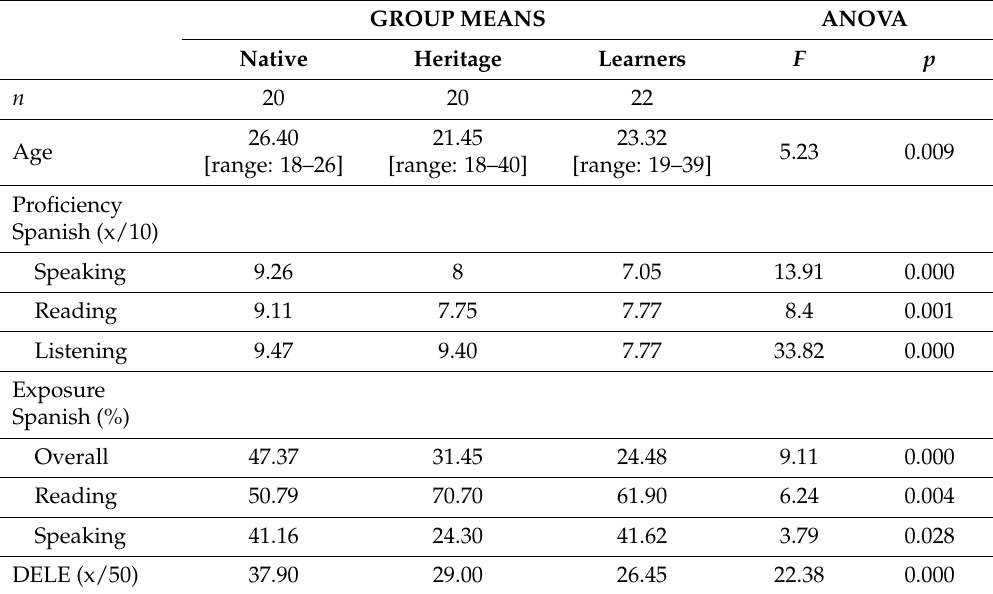
Table 2. Participant